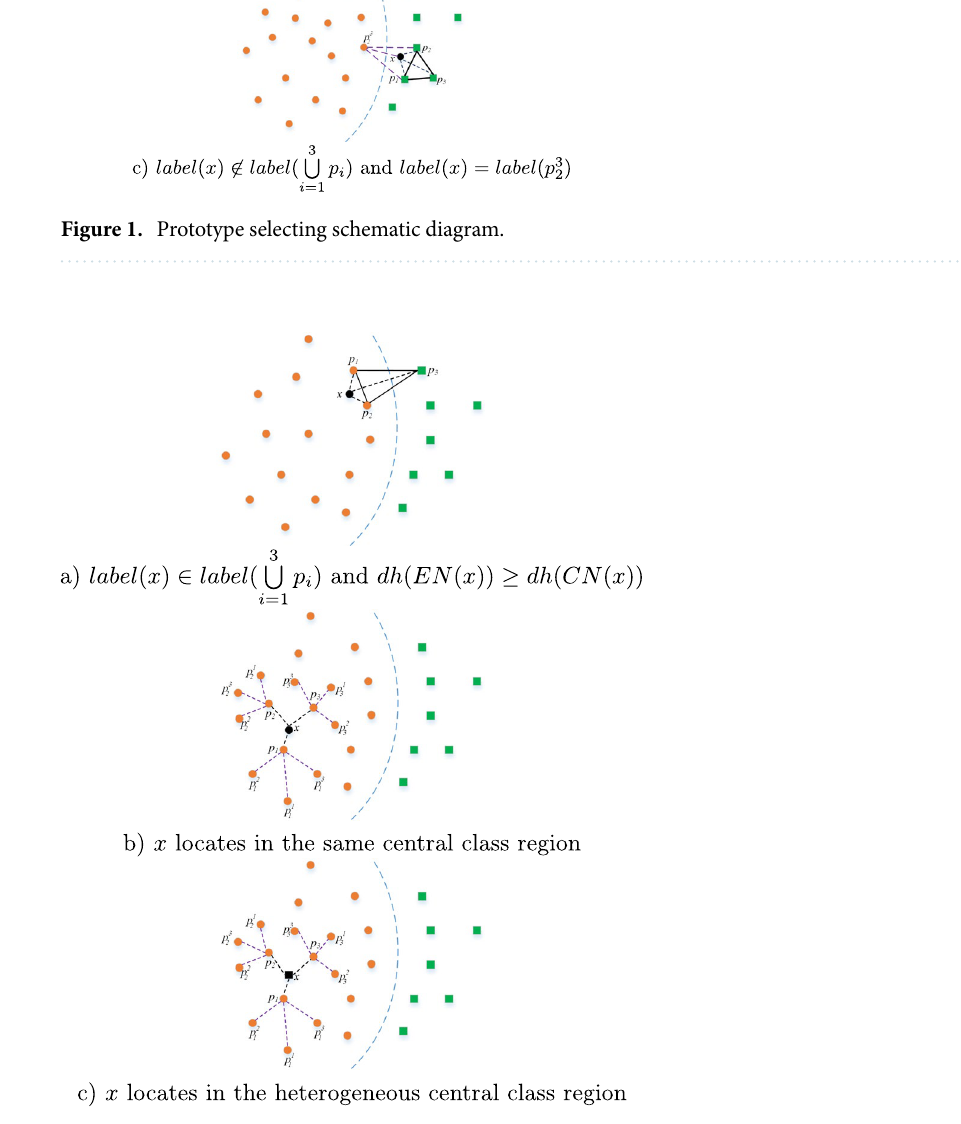
Figure 2. Prototype discarding and updating schematic